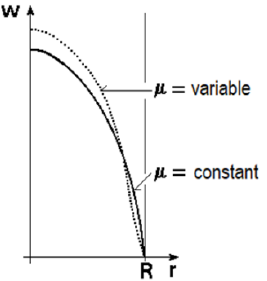
Figure 3. Velocity profiles for constant and variable viscosity [25], reprinted from Springer Nature